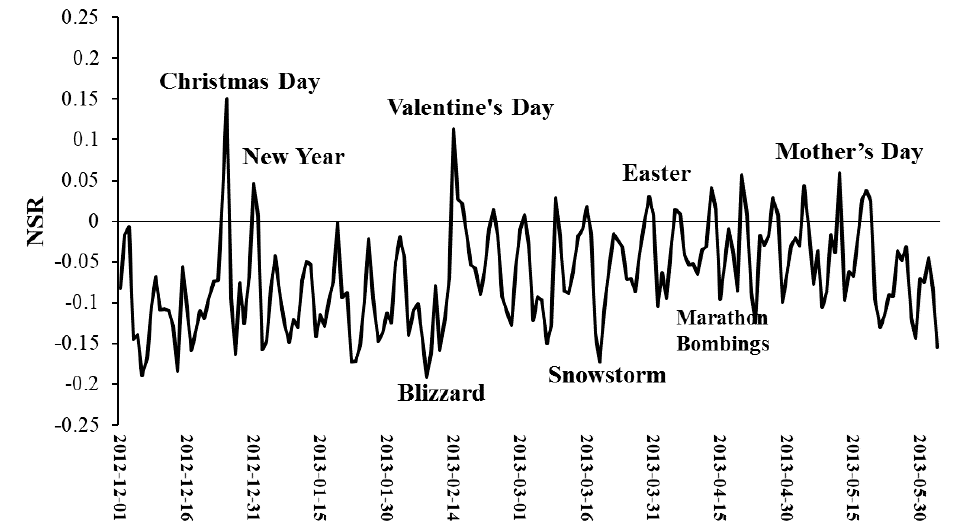
Figure 9. Variations of NSR s during the investigated date range.